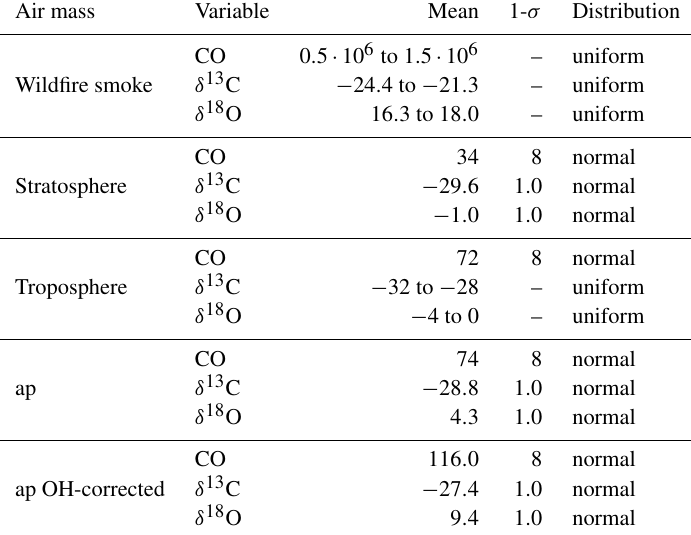
Table 3. Endmember variables and air parcel values and uncertainties as used in the Monte Carlo simulation. Mole fractions are given in part per billion (ppb) and δ values in per mille (‰). Here ap means air parcel and is based on the in situ observation made by LISA (see Table 4). The uncertainties for the mole fractions is set equal to the uncertainty of the LISA observations as discussed in Sect. 2.2.1. The uncertainty of the isotopic composition of the stratosphere, ap, and ap OH-corrected are set equal to twice the measurement uncertainty; see text for a discussion. In the ap OH-corrected, ap is corrected for removal by OH using Eq. (6) with k er = 0. A number density OH of 1 . 2 × 10 6 cm − 3 is used. The stratospheric endmember definition is based on the in situ observation of stratospheric background presented in Table 4. The tropospheric and wildfire smoke endmember definitions are based on observations from earlier work (see text). The large range for the plume mole fraction does not significantly affect the results of the Monte Carlo